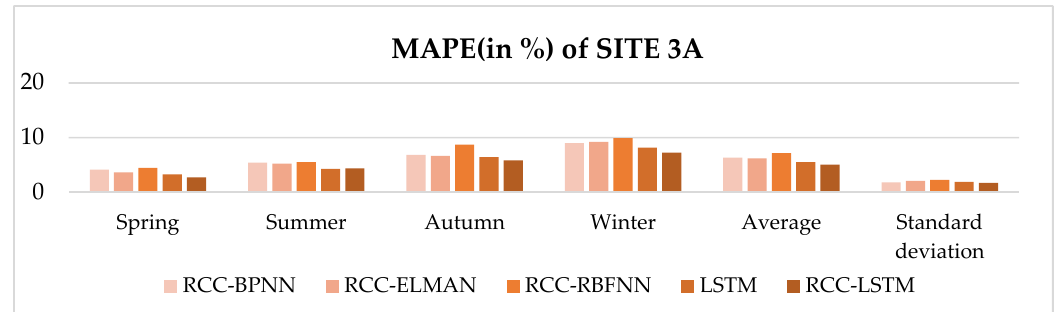
Figure 13. Comparative MAPE (in %) results of SITE 3A.